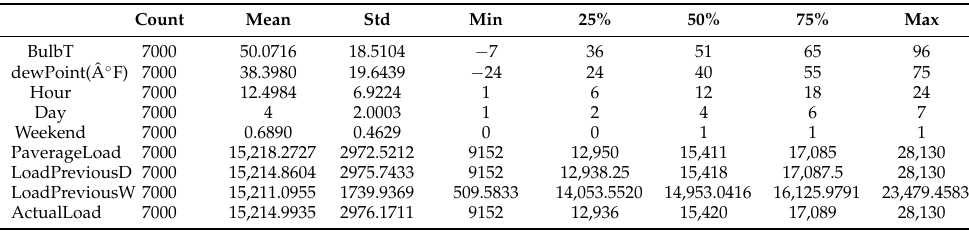
Table 1. The numerical values for the 8 inputs and 1 output with